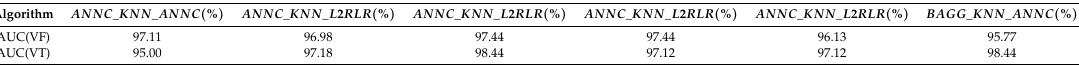
Table 17. AUC for HM classification combination methods in detection of VF and VT